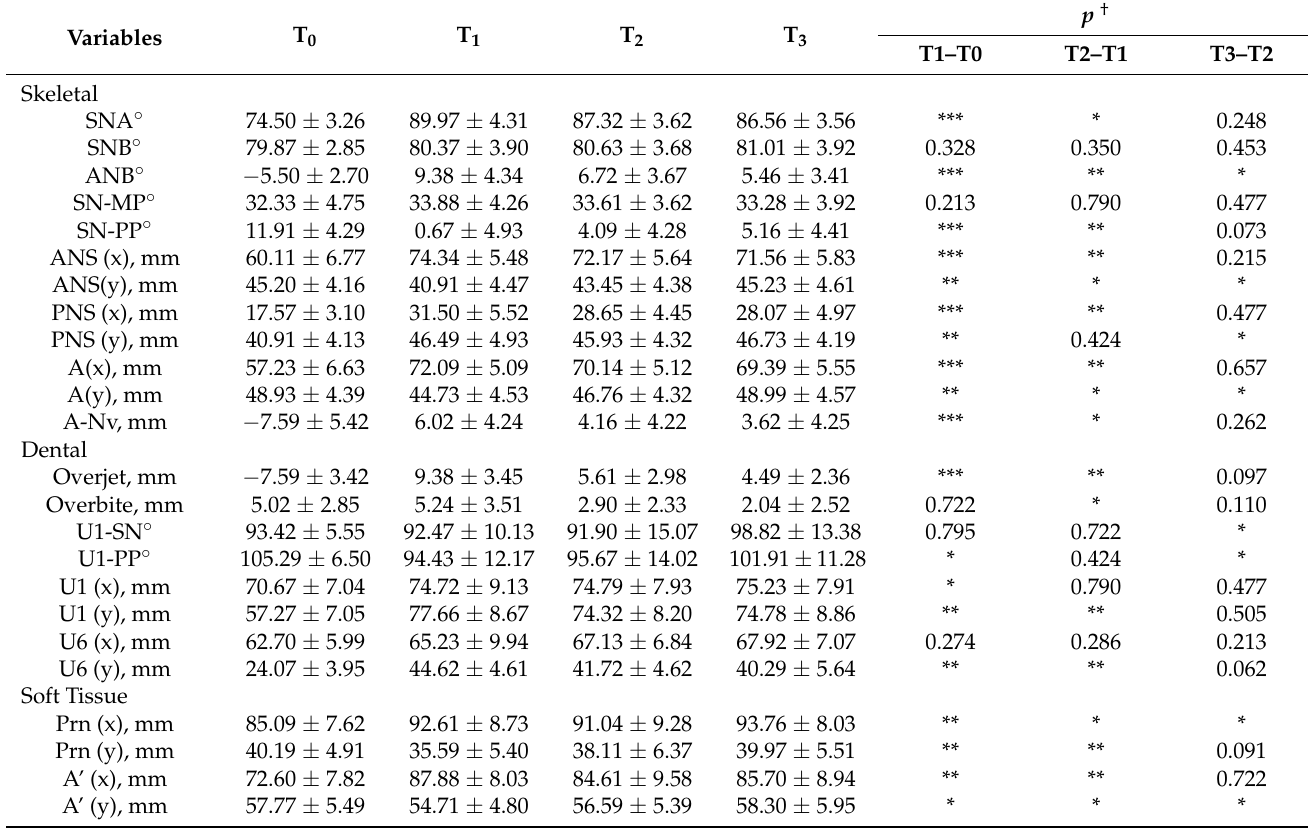
Table 4. The mean changes of the skeletal, dental and soft tissue components based on serial cephalograms in the traditional tooth-borne RED group.